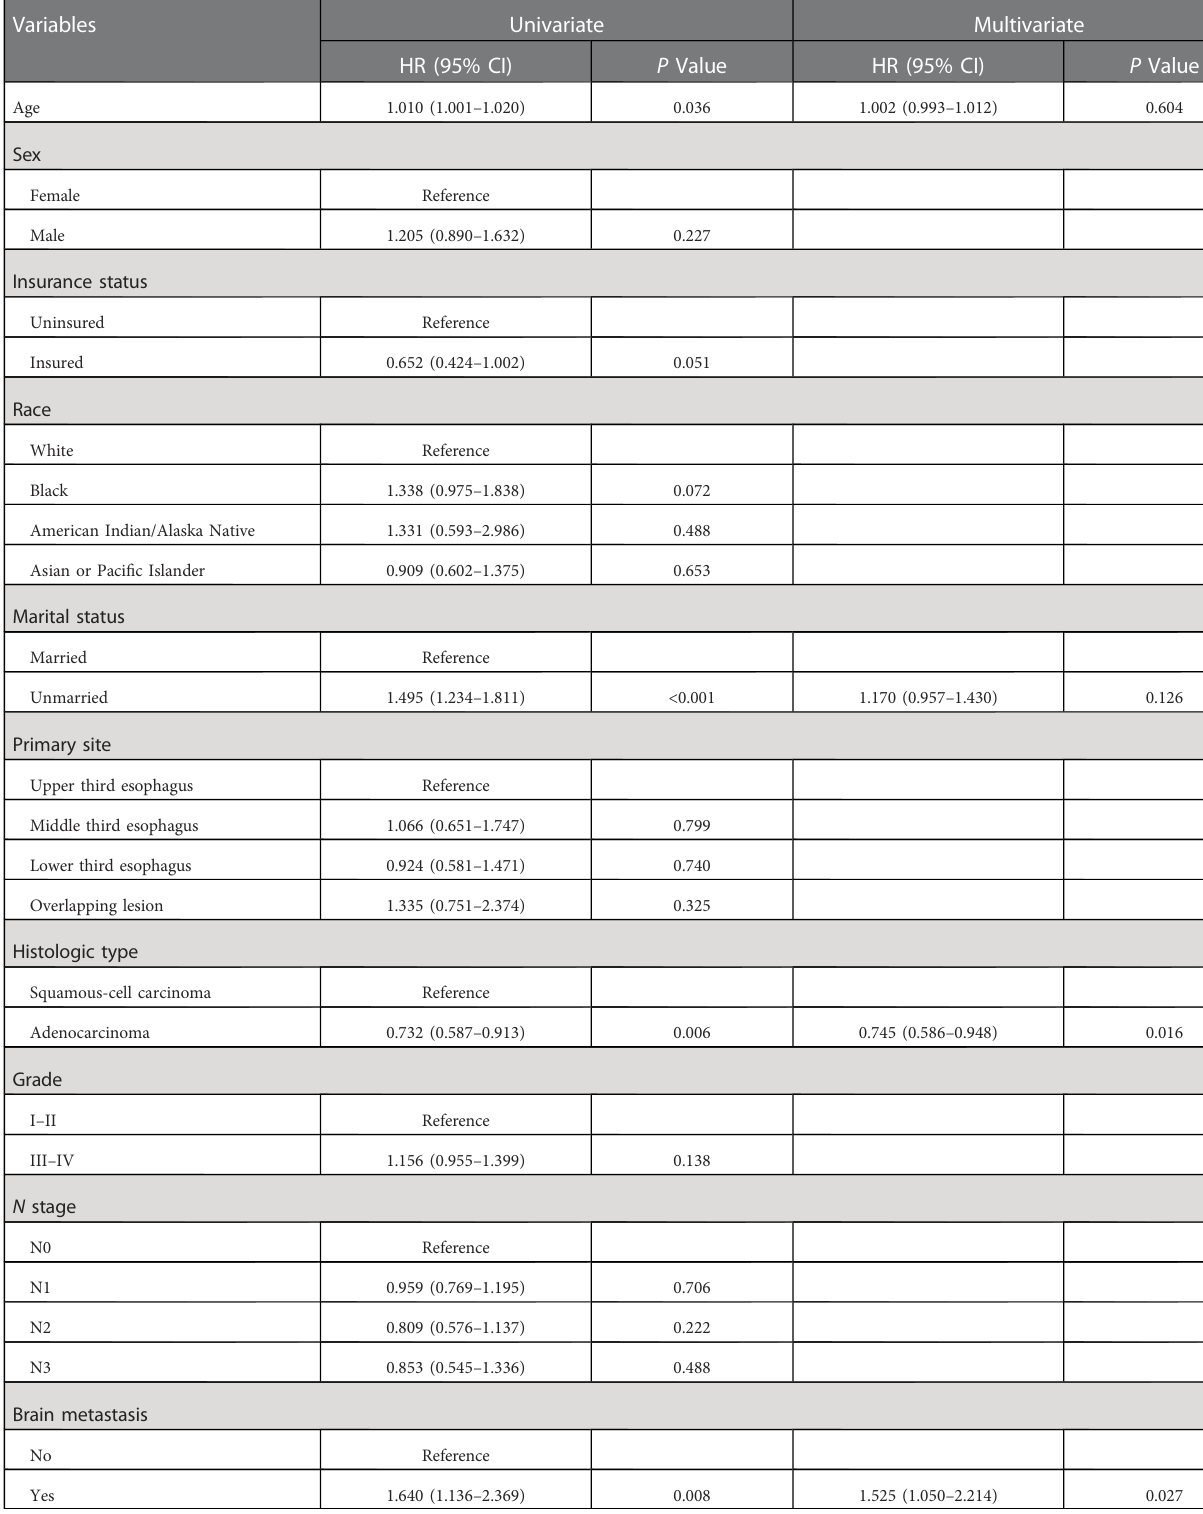
TABLE 5 Univariate and multivariate cox regression analyses in esophageal cancer patients with bone